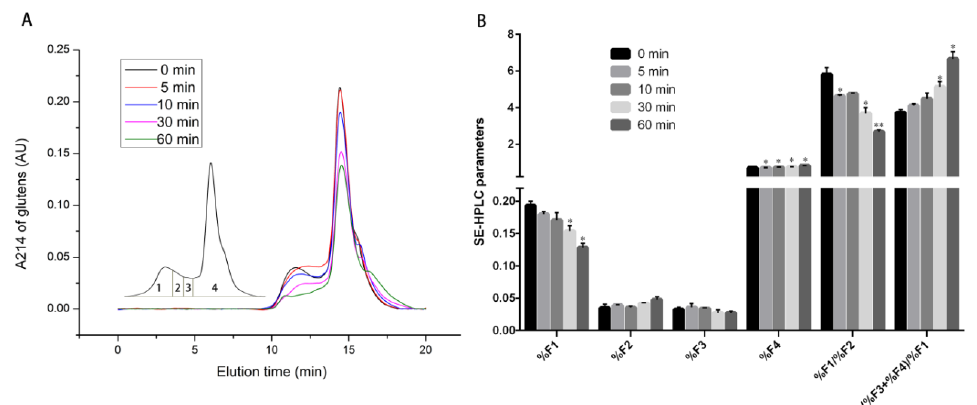
Figure 11. The influence of CJAP plasma on the aggregate formation of wheat gluten proteins. ( A ) SE-HPLC chromatogram curve of native and CJAP plasma-modified wheat gluten proteins. The inset refers to the area division of the wheat storage protein distribution, which corresponded to large-sized polymers (F1), medium-sized polymers (F2), monomeric and oligomeric proteins (F3) and monomeric gliadins and non-gluten proteins (F4). ( B ) with corresponding comparisons of six parameters (%F1, %F2, %F3, %F4, %F1/%F2, and (%F3 + %F4)/%F1) analyzed statistically. Data are presented as means ± SE ( n = 3) in the assays. Asterisks represent statistically significant differences from 0 min (* p < 0.05, ** p < 0.01).